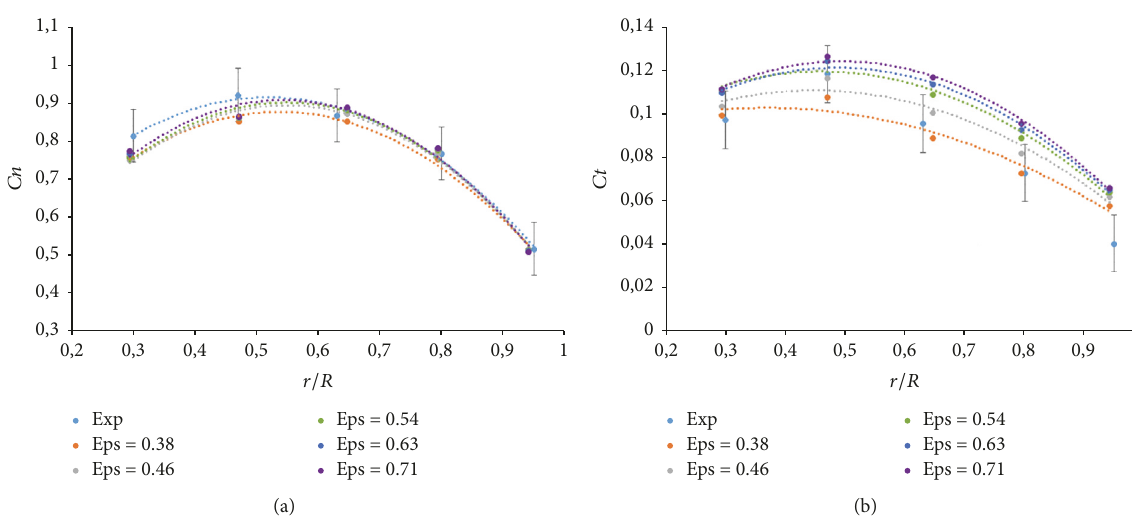
Figure 3: Normal (a) and tangential (b) force coefficient along the blade.